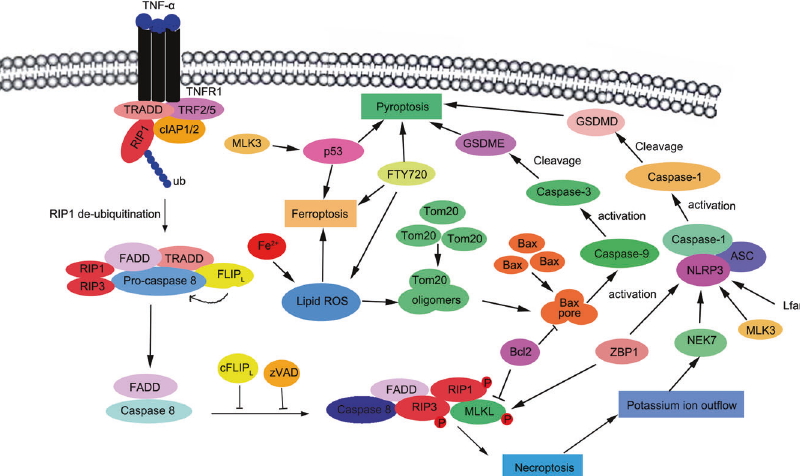
Fig. 4 The crosstalk between necroptosis, pyroptosis, and ferroptosis. Several studies showed that there is an interaction between necroptosis, pyroptosis, and ferroptosis. RIP1 or RIP3-mediated necroptosis contributes to the membrane damage. Potassium ion out fl ow activates NEK7, which leads to the cleavage of GSDMD. Additionally, Iron activates ROS for GSDME-dependent pyroptosis in melanoma cells, suggesting there is a crosstalk between ferroptosis, pyroptosis and